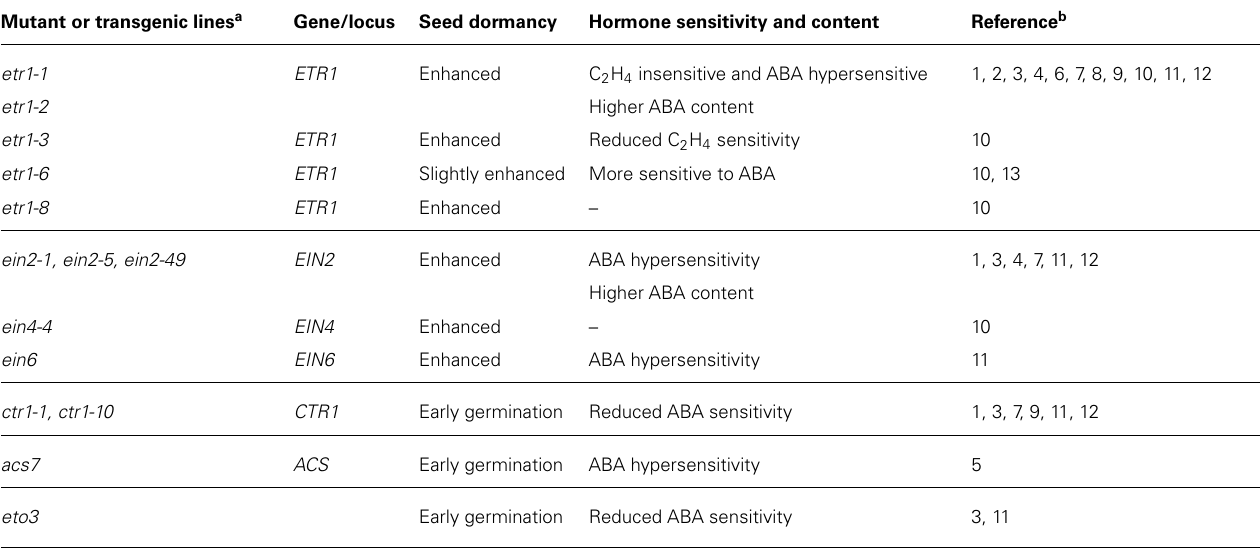
Table 2 | Dormancy andABA sensitivity of various mutants of Arabidopsis thaliana affected in ethylene biosynthesis or signaling pathway. Mutant or transgenic lines